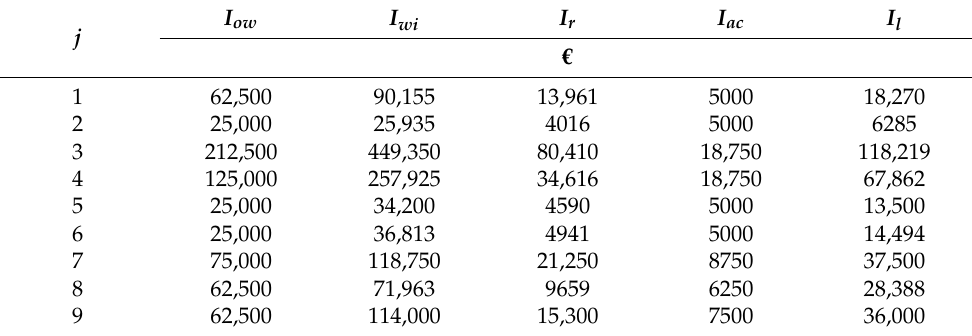
Table A2. Investment costs for individual buildings and energy saving measures considered. I = in- vestment cost ( € ), ow = outer walls insulation, wi = windows replacement, r = roof insulation, ac = air conditioning unit refit, l = lighting refit, j = building number (1 to 25)